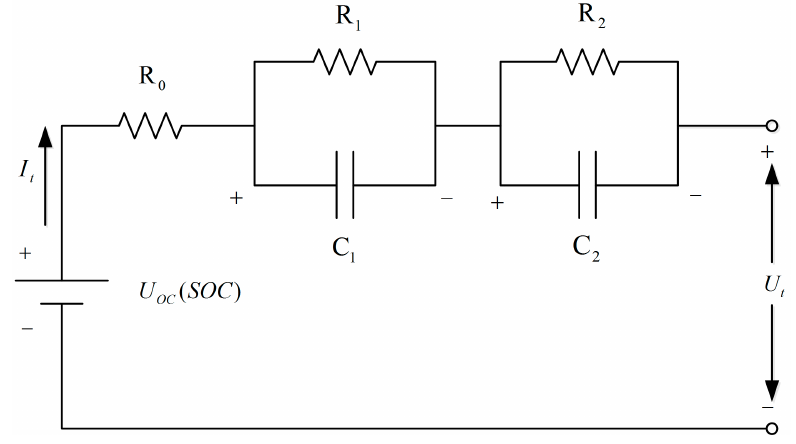
Figure 1. Second-order RC equivalent circuit model.